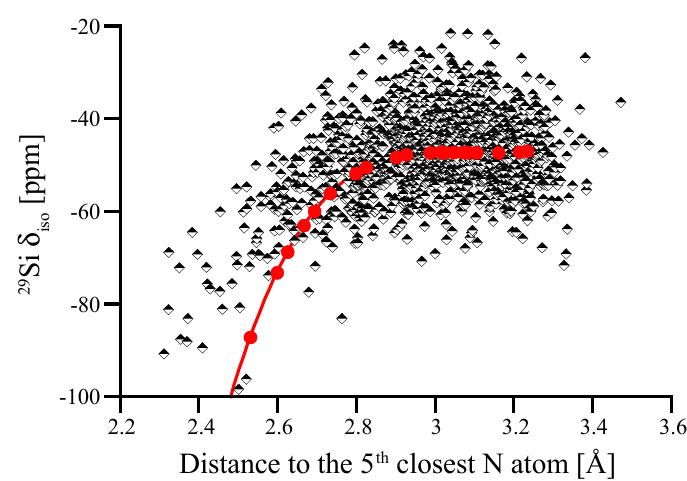
Figure 9. 29 Si NMR δ iso plotted versus the distance to the 5th nearest N atom. Black-and-white dots represent computed results for the amorphous models. Red dots and line are results for distorted wII-Si 3 N 4 models (see Figure 3b).